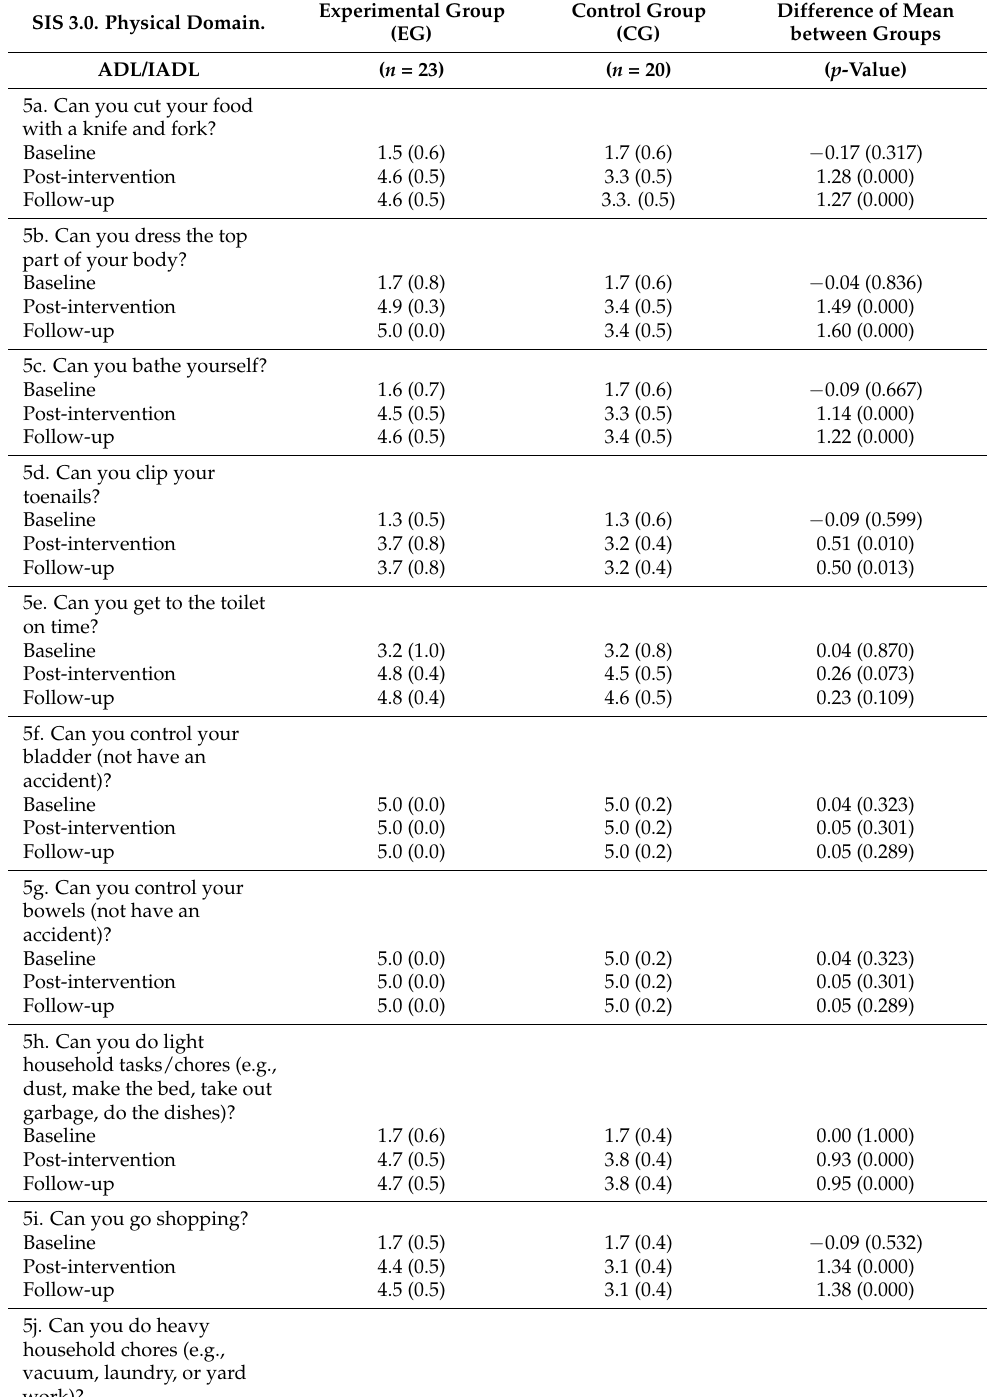
Table 4. Difference in means of physical domain (ADL/IADL) according to intervention group as measured by SIS 3.0 ( n =